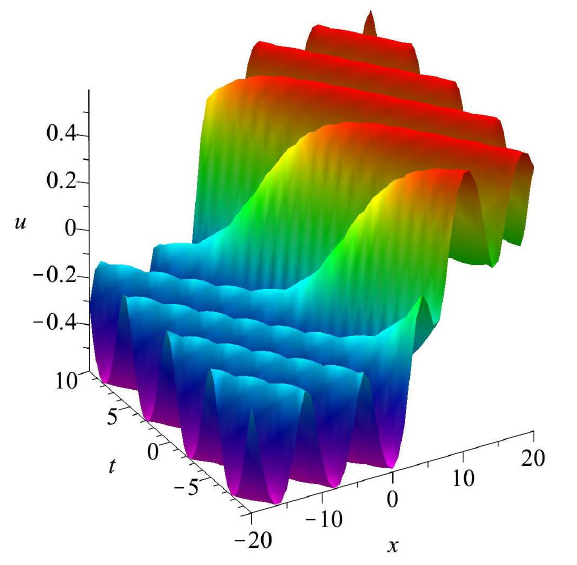
Figure 1. Plot of one kink soliton on the cnoidal wave background expressed by ( 17 ) of the nonlocal mKdV equation in three